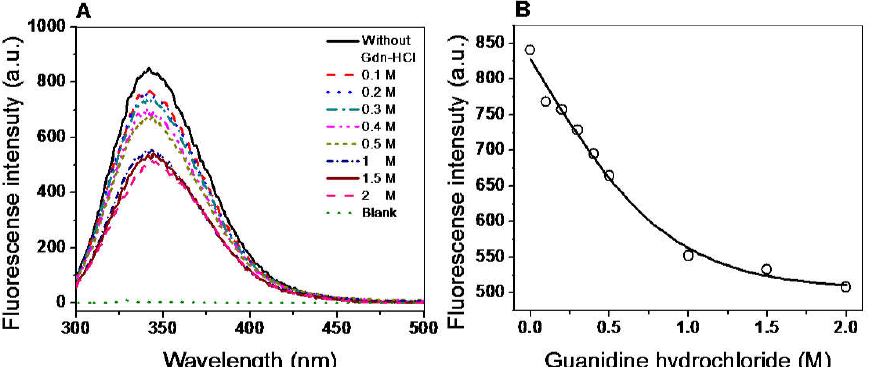
Figure 9. Structural analysis of G6PD::6PGL by intrinsic fluorescence. ( A ) Intrinsic fluorescence spectra in the presence of Gdn-HCl. ( B ) Effect on the intrinsic fluorescence at different concentrations of Gdn-HCl. The protein was incubated at 0.1 mg/mL in 50 mM Tris buffer pH 8.75 in the presence of the indicated concentrations of Gdn-HCl for two hours at 37 ◦ C and subsequently the intrinsic fluorescence was measured. The experiments were performed in triplicate and the standard errors were less than 4%. Values obtained from buffer containing Gdn-HCl without protein were subtracted from the measurements of G6PD::6PGL